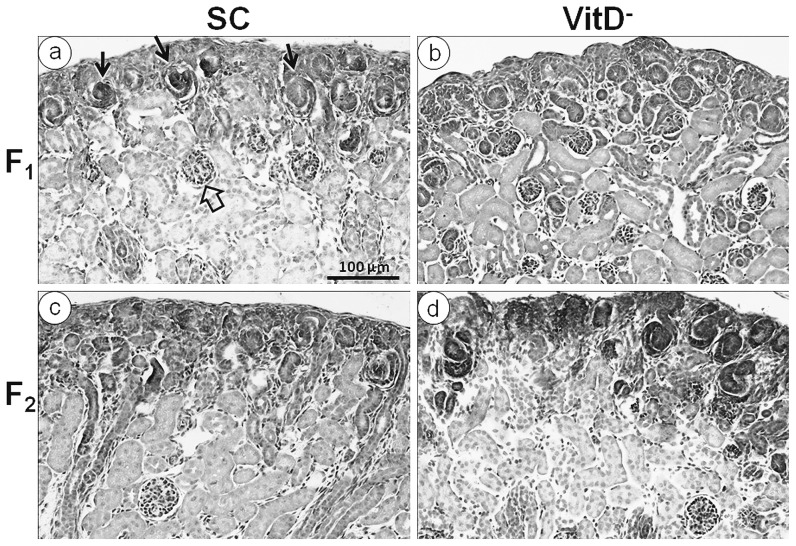
Photomicrographs of the developing kidneys of offspring at birth.Hematoxylin and eosin stain, same magnification in all pictures. (a) SC offspring and (b) VitD- offspring in the F1 generation; (c) SC offspring and (d) VitD- offspring in the F2 generation; (arrows) clusters with comma-shaped and S-shaped glomerular structures at the cortex; (open arrows) vascularized glomerular structures in the inner region.